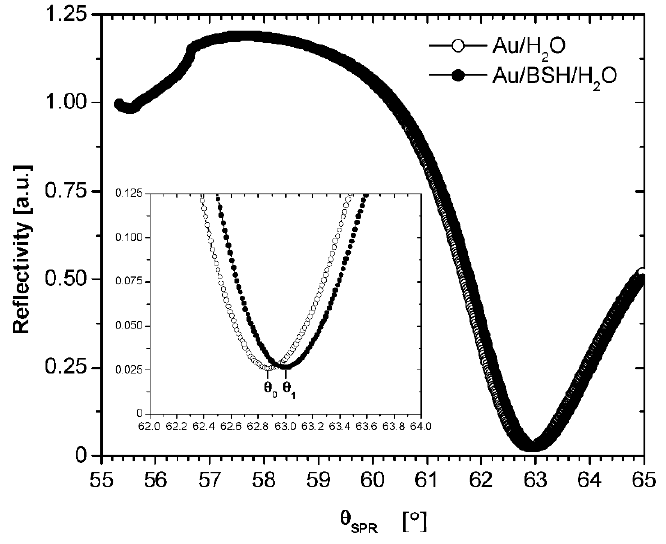
Figure 5. Normalized θ SPR angular scan curves of reflectivity versus incident angle for a boron cage (BSH) self-assembled monolayer, resonance angle of Au/H 2 O ( θ 0 ) before adsorption, and resonance angle ( θ 1 ) after [B 12 H 11 SH] 2 − adsorption.